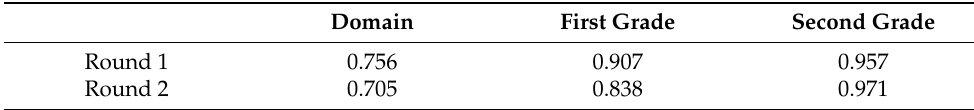
Table 4. Test results of reliability ( Cronbach’s α ).